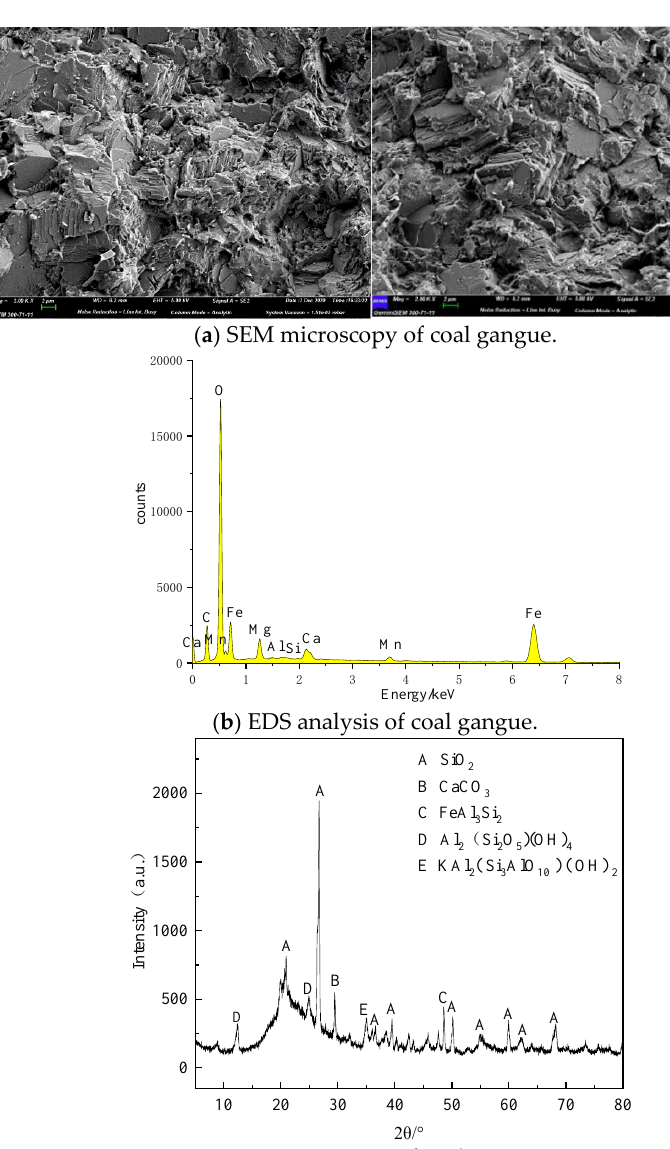
( c ) XRD spectrums of coal gangue. Figure 4. Microstructure of coal gangue. Figure 4. Microstructure of coal Table 1. Chemical elements of coal gangue (atomic fraction)/wt.%.